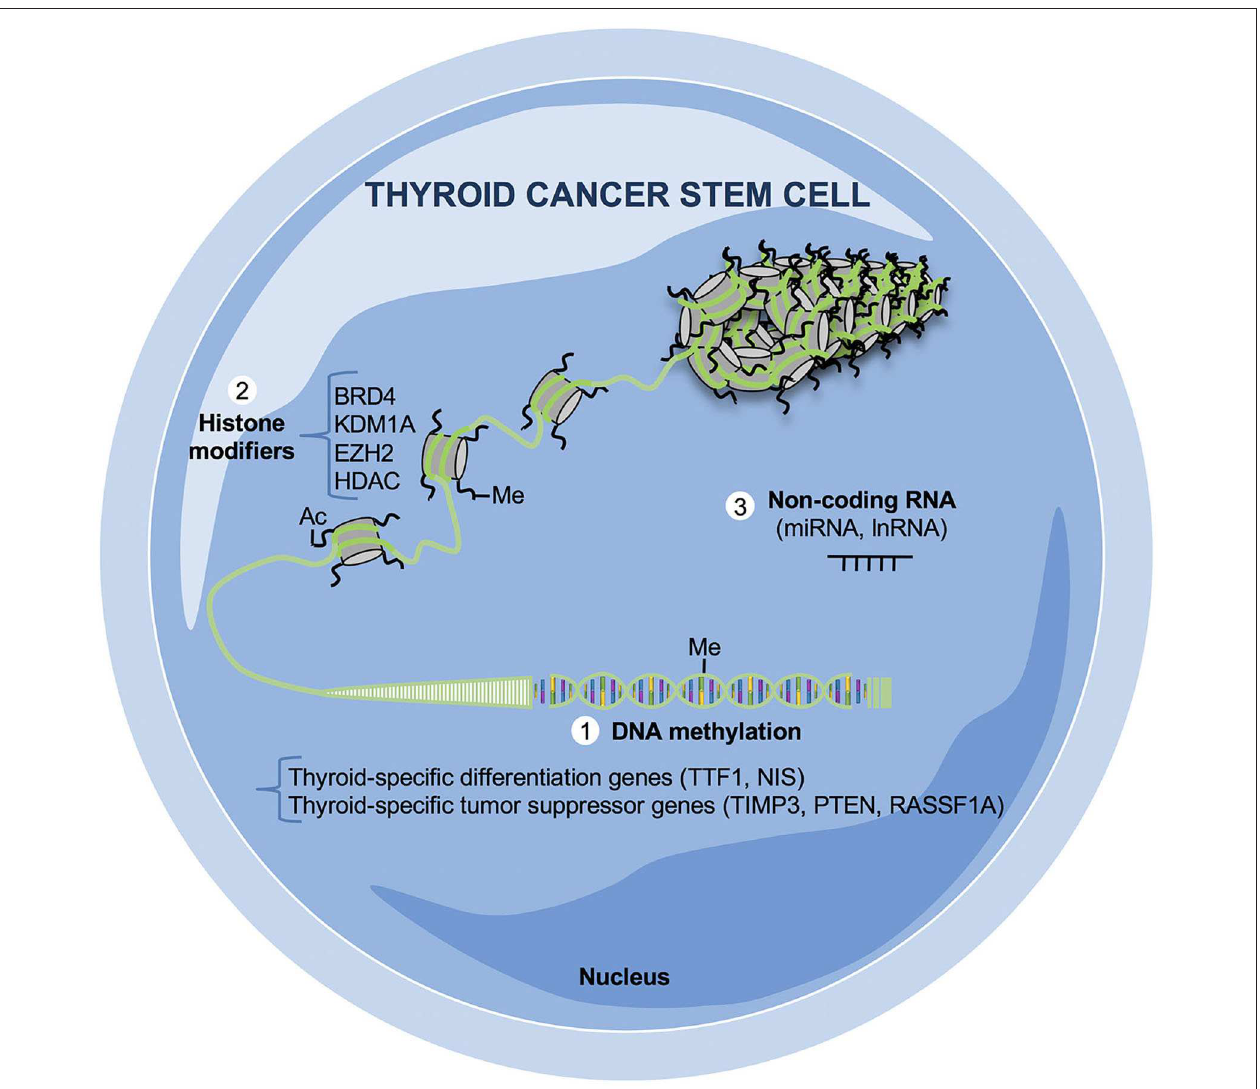
FIGURE 2 | Epigenetic mechanisms relevant in thyroid cancer stem cells (TCSCs). Altered epigenetic mechanisms crucial for the survival of TC cells and, in particular for TCSCs, have not completely elucidated yet. The majority of aberrant epigenetic events in TCs are based on (1) DNA methylation: the promoters of thyroid-specific differentiation as transcriptional thyroid factor 1 ( TTF1 ) and sodium iodide symporter ( NIS ) and of tumor suppressor genes as tissue inhibitor of metalloproteinase-3 ( TIMP3 ), phosphatase and tensin homolog ( PTEN ), Ras association domain family 1 isoform A ( RASSF1A) are silenced by hypermethylation; (2) histone